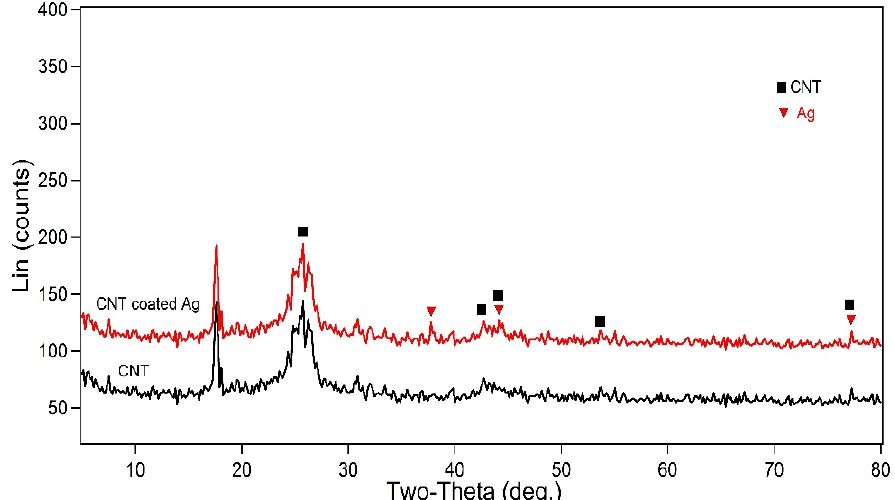
Figure 3. XRD lines of MWCNTs with and without Ag coating.